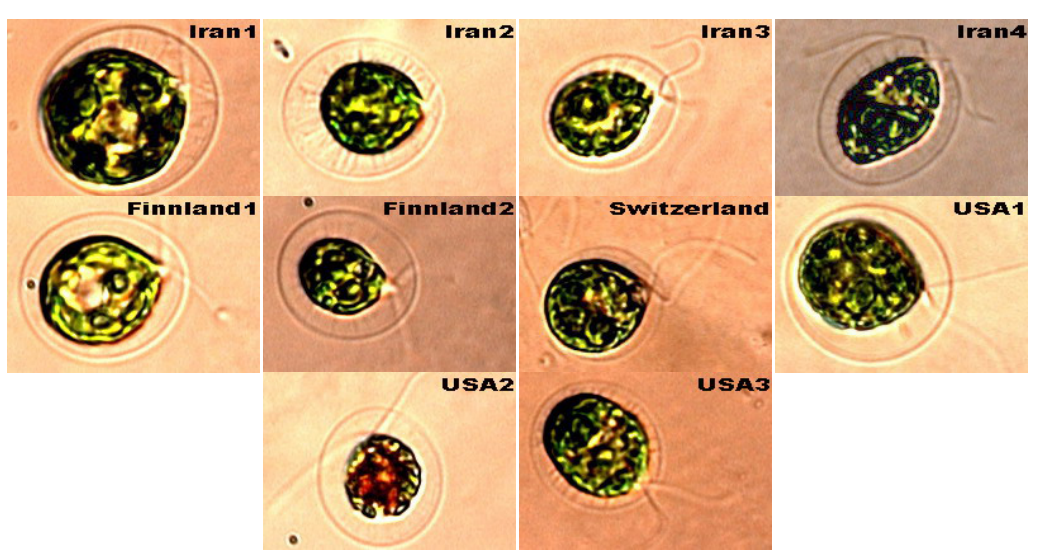
Figure 1. The morphology of ten strains of H.